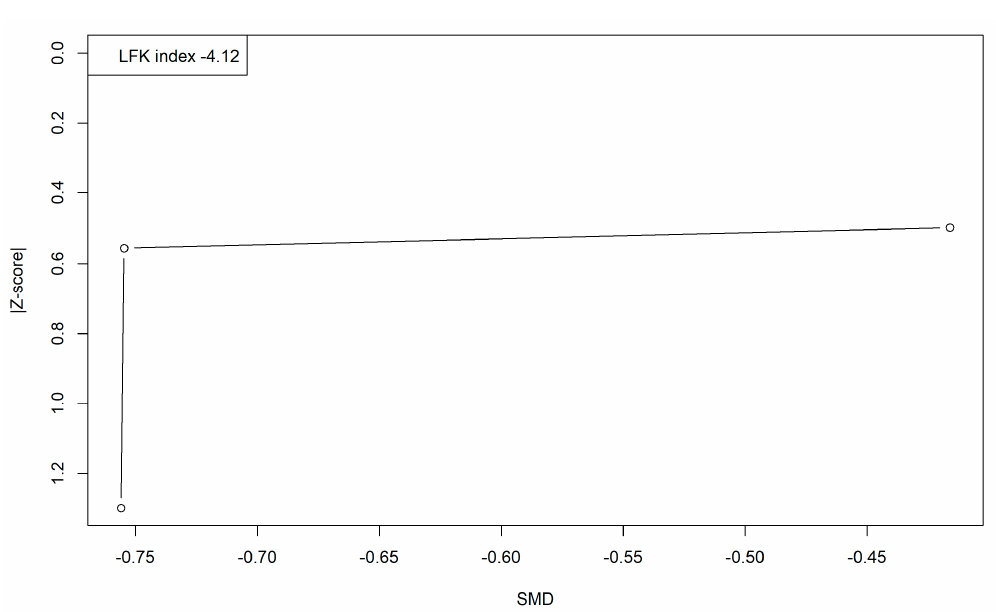
Doi plot and LFK index of the studies included in the sensitivity analysis